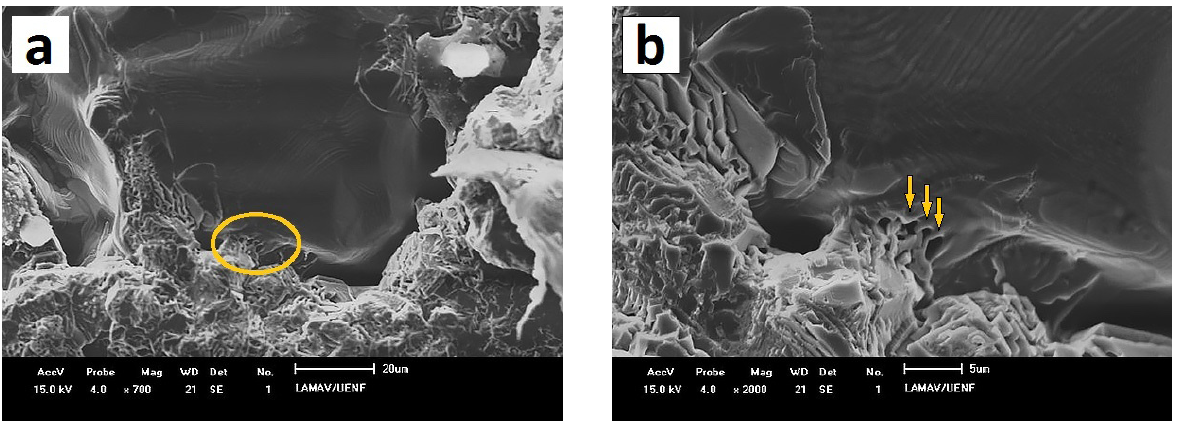
Figure 9 - Cell adhered on titanium surface ( a ). Circular region marked in Figure a at higher magnification ( b ), whose arrows point to possible cytoplasmic extensions towards the surface of Ti.